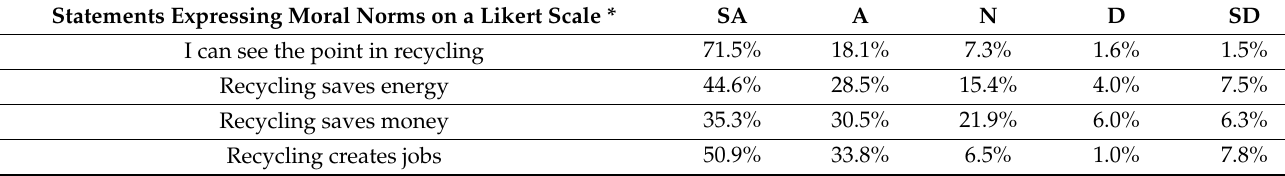
Table 10. Consequences of recycling.